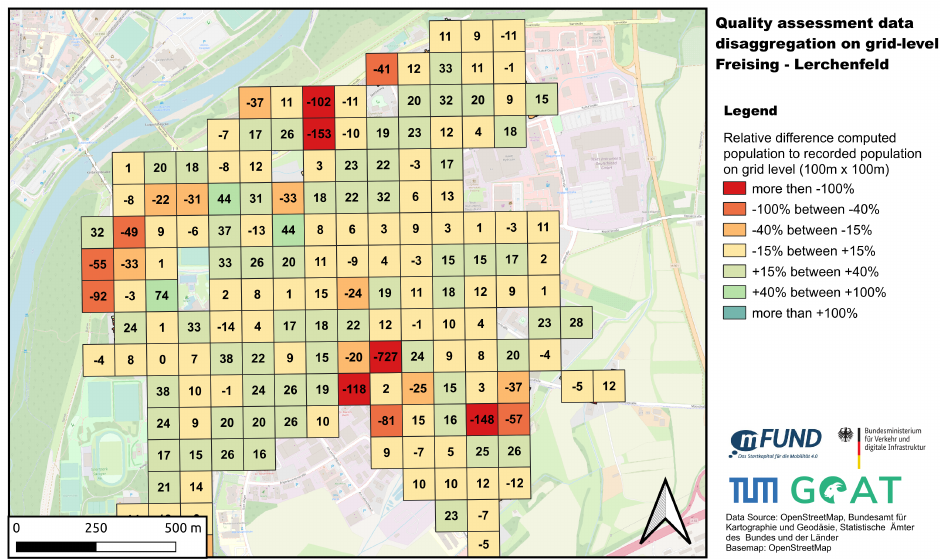
Figure 18. Comparison disaggregated and recorded population on grid-level.